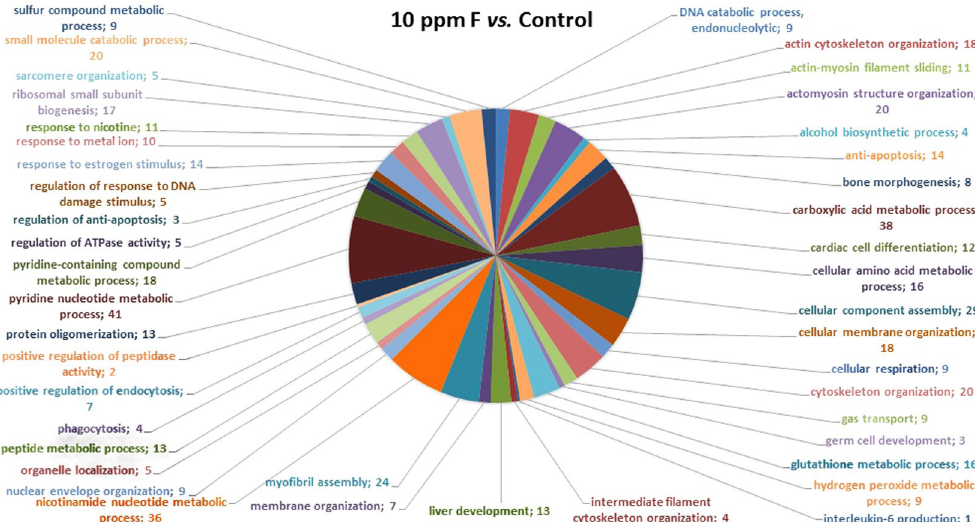
Figure 1. Functional distribution of proteins identified with differential expression in the duodenum of rats exposed chronically to 10 ppm F vs. Control Group (0 ppm F). Categories of proteins based on GO annotation Biological Process. Terms significant (Kappa = 0.04) and distribution according to percentage of number of genes association. Proteins access number was provided by the UNIPROT. The gene ontology was evaluated according to ClueGo ® pluggins v2.0.7 of Cytoscape ® software 36, 37 .